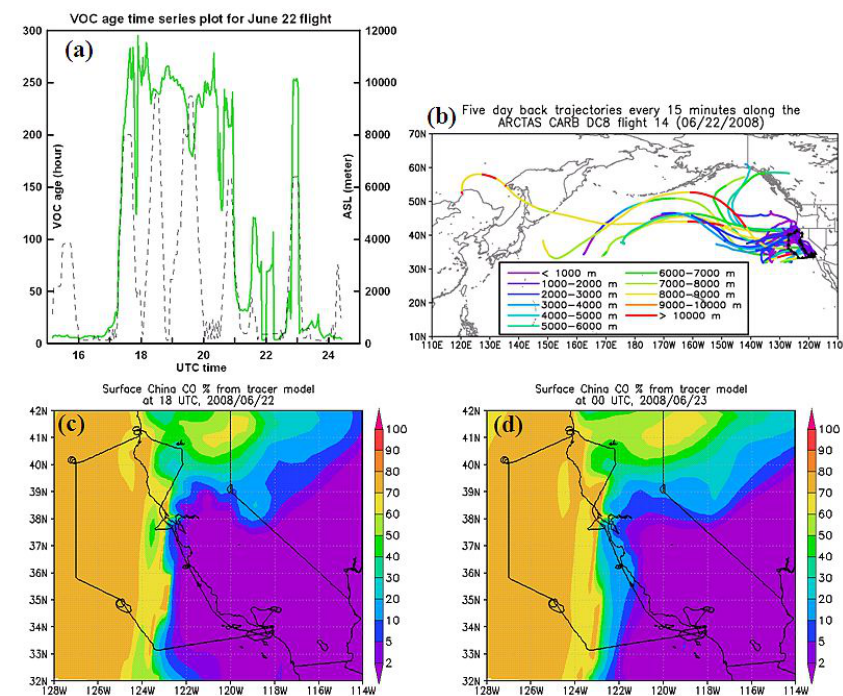
Fig. 2. (a) VOC ages and (b) five-day back trajectories along the 22 June DC-8 flight path; tracer surface contributions of anthropogenic China CO as % over California during flight time (c) 18:00UTC (d) 24:00UTC (00:00UTC, 23